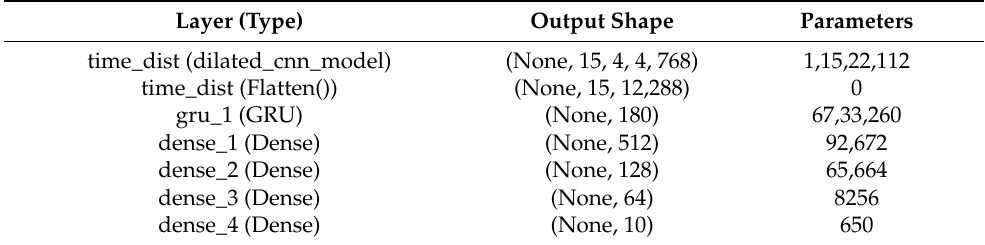
Table 4. Model architecture for